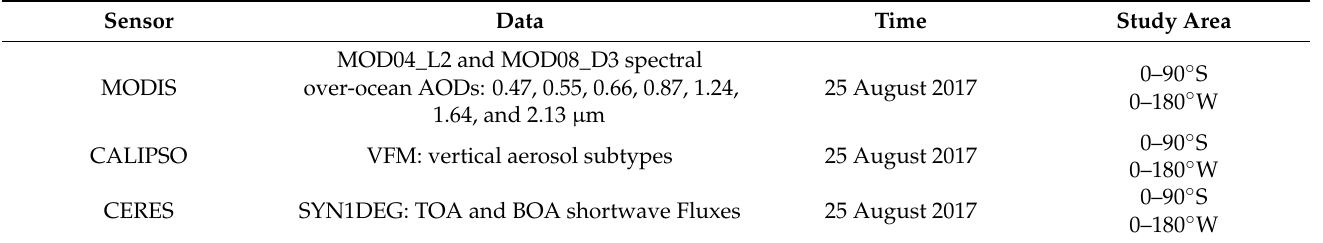
Table 2. Satellite-derived aerosol products utilized in the study.